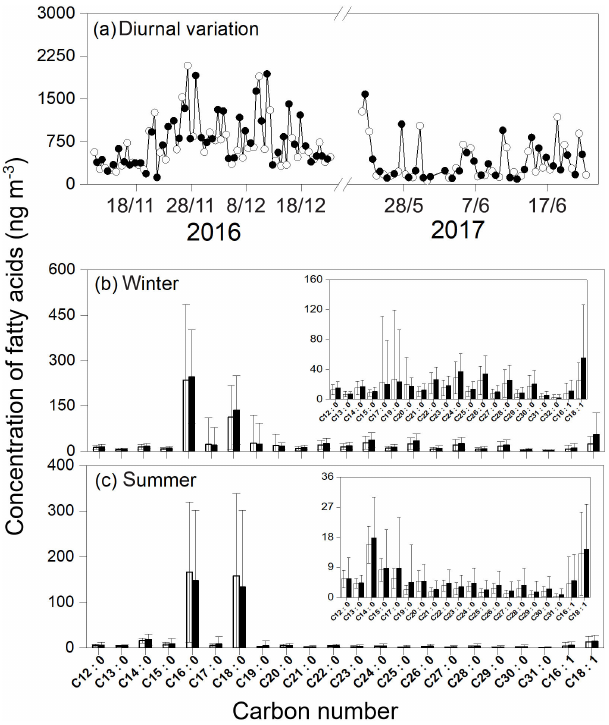
Figure 4. Temporal variations (a) and molecular distribution of fatty acids during the wintertime (b) and summertime (c) in Tianjin (white and black represent day- and night-time respectively). The inset figures in (b) and (c) are the molecular distributions of fatty acids excluding C 16 : 0 and C 18 : 0